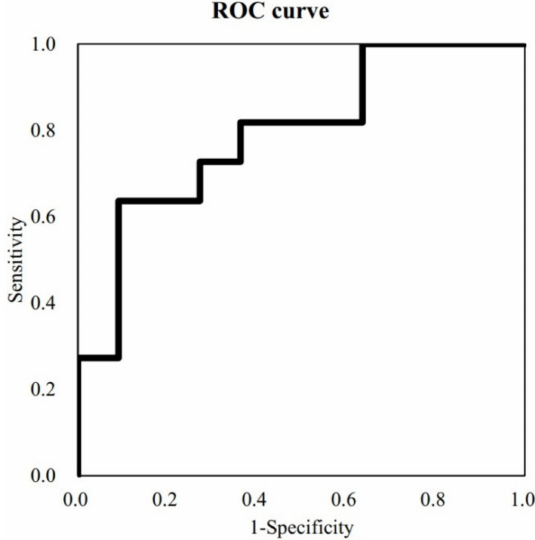
Figure 4. Good and poor recovery were determined based on Brunnstrom stage of upper-limb function at 6 months as the standard, and ROC (Receiver-operating characteristic) curve indicated that a cuto ff score of 0.013 had the greatest prognostic ability (maximum sensitivity and